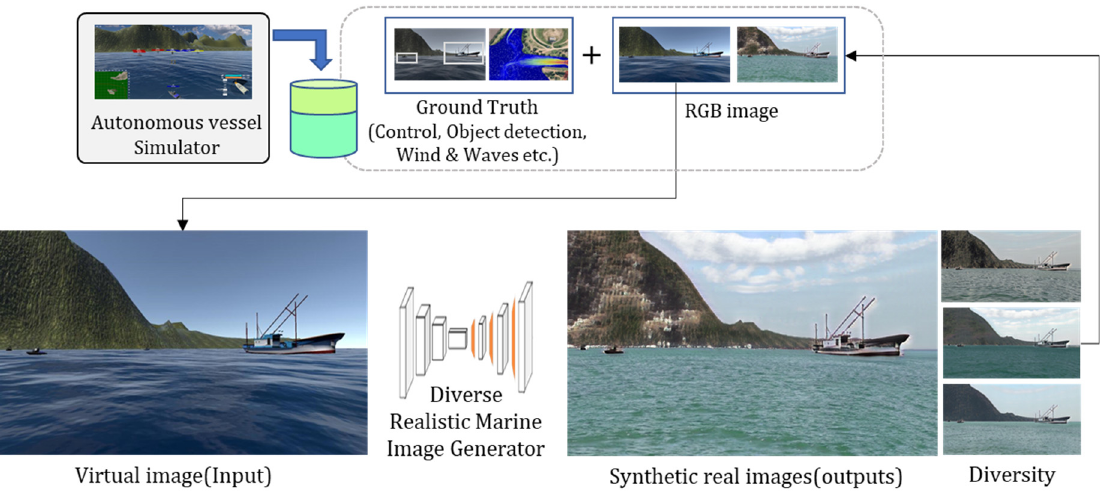
Figure 1. Concept of realistic generation of diverse marine images for training autonomous vessels.